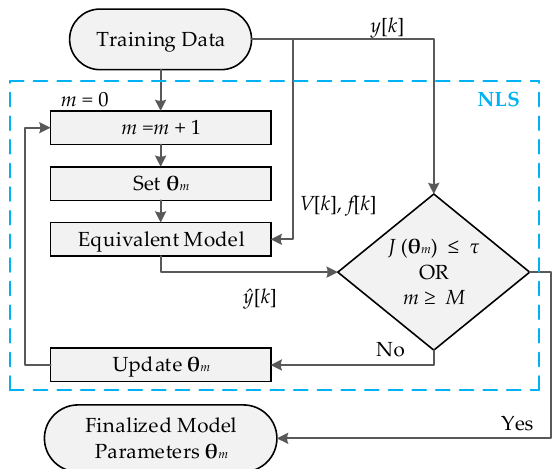
Figure 2. Flowchart of parameter estimation procedure.